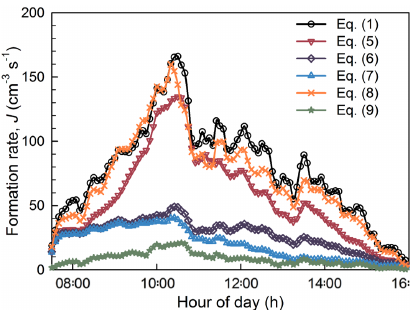
Figure 3. Comparison of formation rates estimated by different for- mulae.